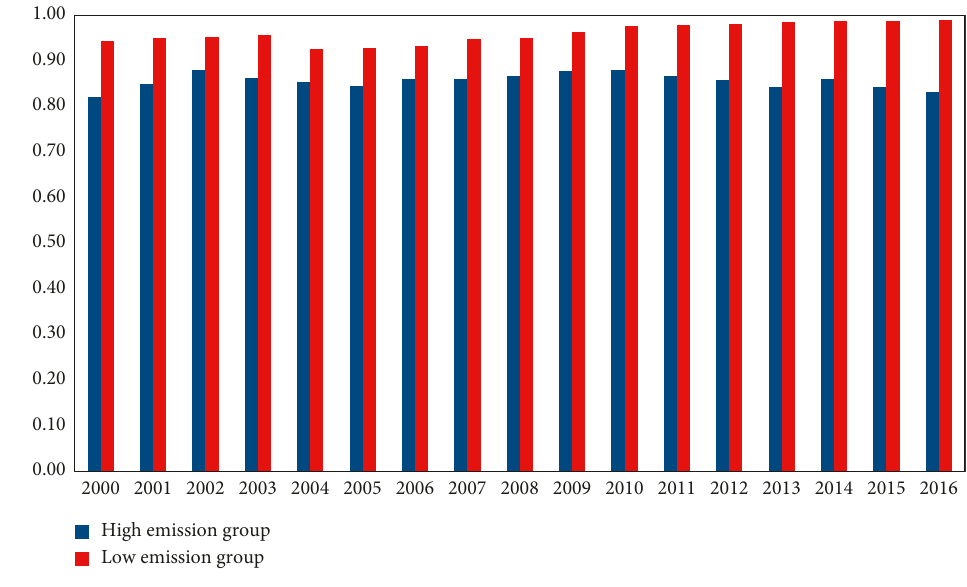
Figure 1: Trends in group green efficiency of different groups. Table 4: Group green efficiency of China’s industrial